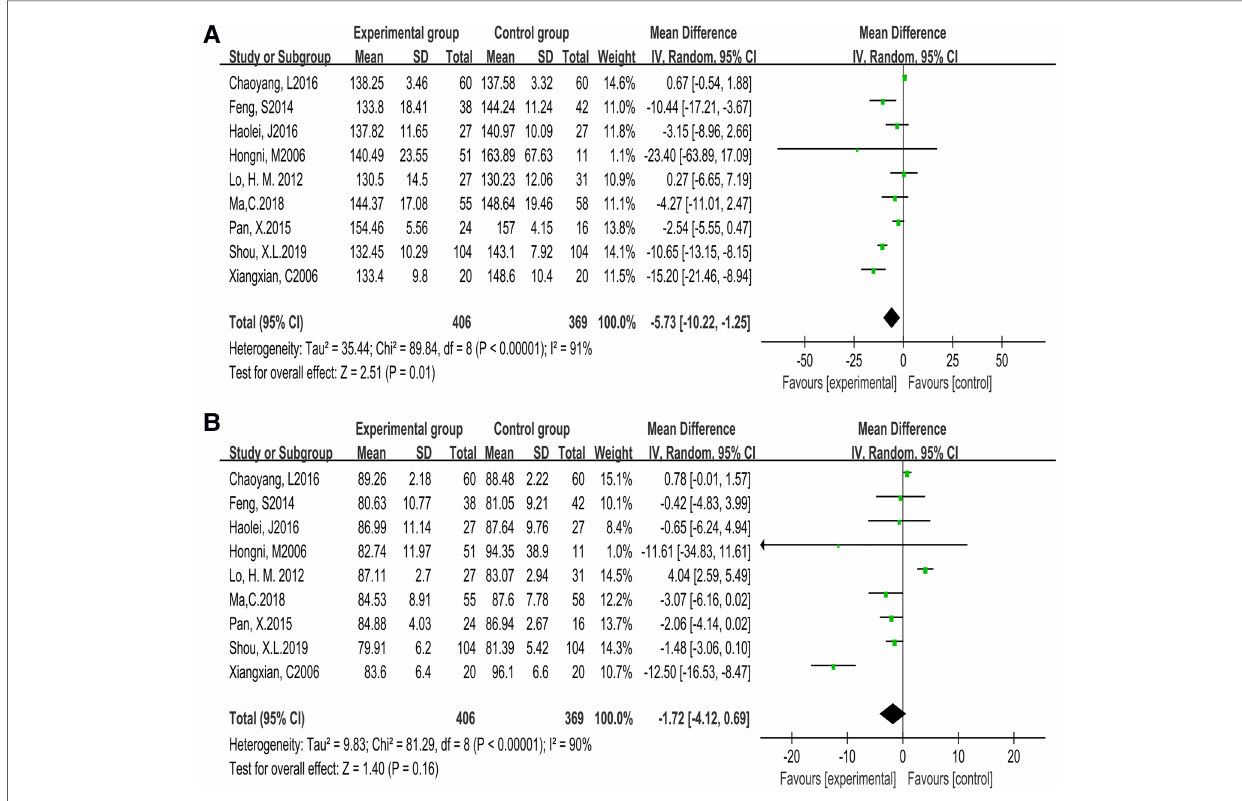
FIGURE 3 Forest plot of meta-analysis on the effect of Tai Chi exercise cycle on blood pressure (cycle <12 weeks). A , systolic blood pressure (SBP); B , diastolic blood pressure